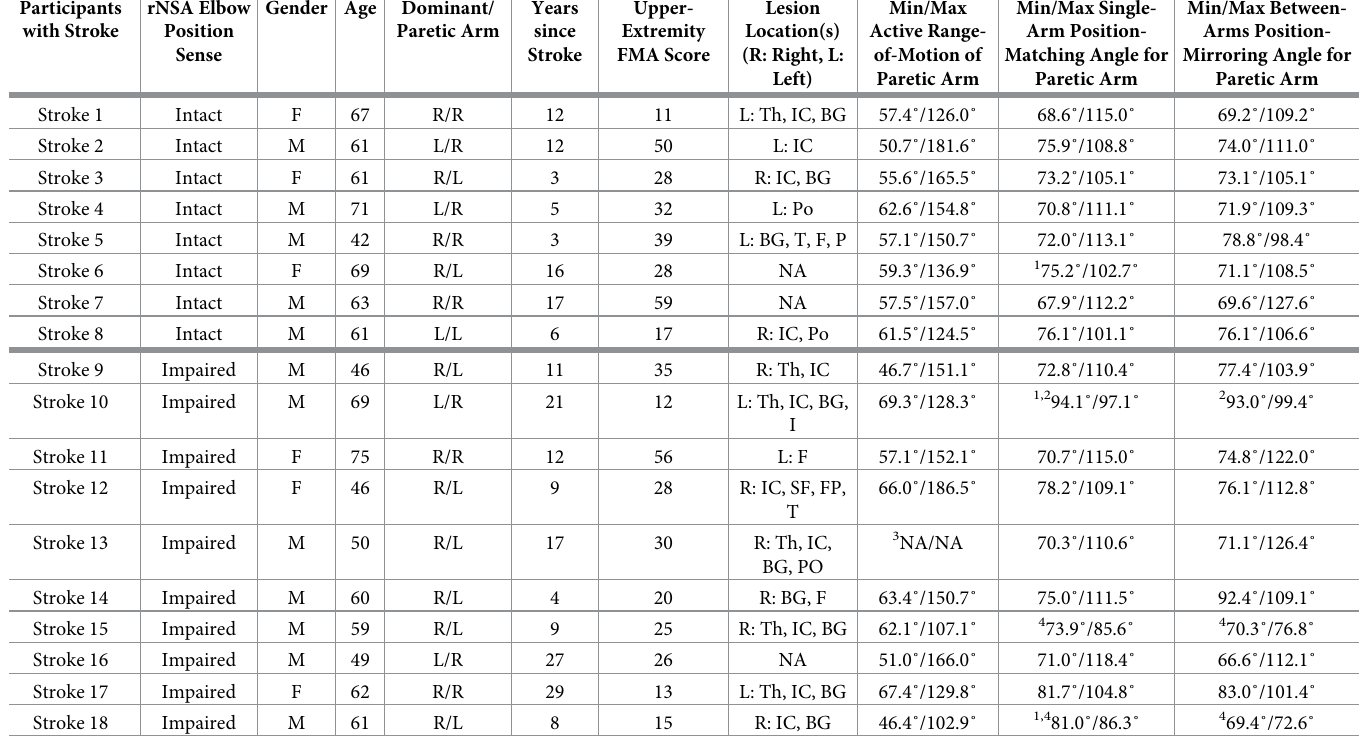
Table 1. Information relevant to participants with stroke. Provided are demographic and clinical information for each participant with stroke. Additionally, provided is the minimum and maximum active range-of-motion for the participant’s paretic arm, along with the minimum and maximum angles at which the participant actively matched and mirrored the reference target location using their paretic arm. Using this information, we verified that the ability of our participants with stroke to match and mirror positions was not compromised due to a limited active